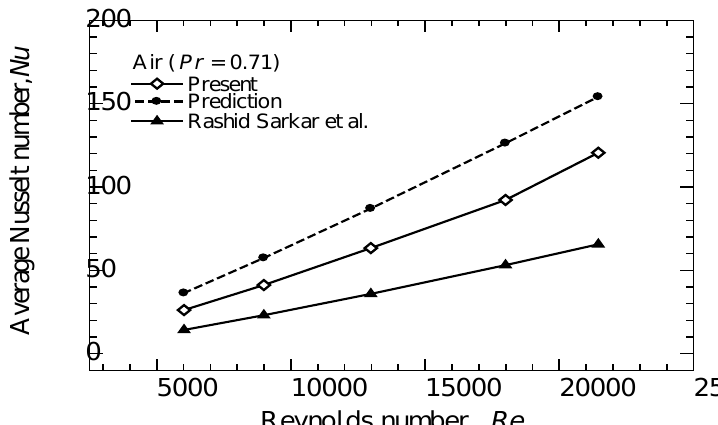
Figure 14: Prediction of heat transfer coefficients for wire-coil inserted tube (Pitch, P c =24 mm, helix angles, α =20 0 ).